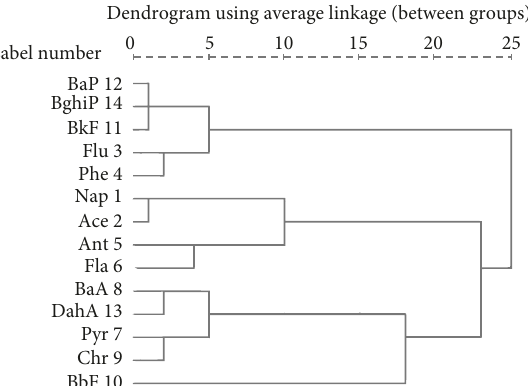
Figure 4: Hierarchical dendrogram for 14 PAHs in the Qinhuai River sediments using average linkage between groups and Pearson correlation as measure